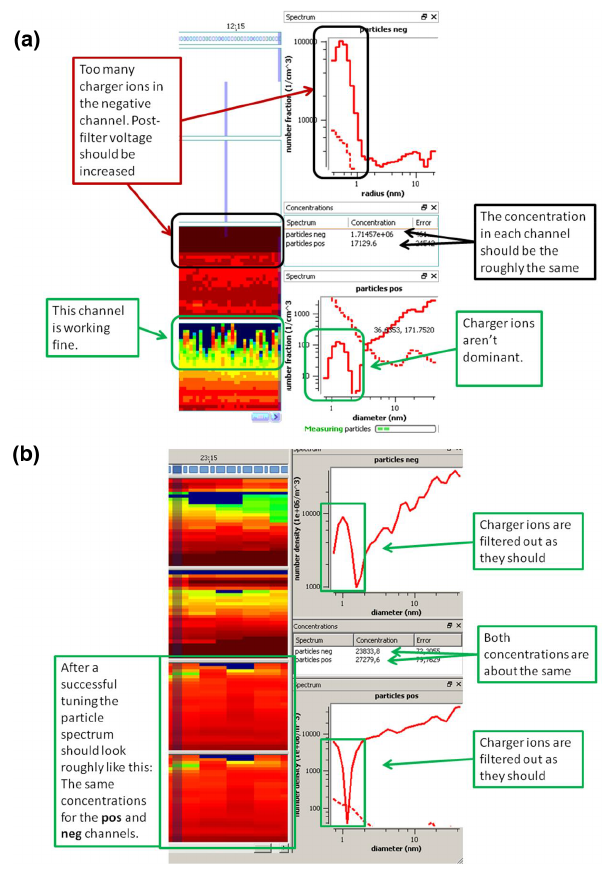
Figure 9. Adjusting post-filter during the particle measurement mode: (a) what to look for, when tuning the post-filter voltage for a bad column (here negative polarity), and (b) how the particle num- ber size distribution should look like after the tuning.